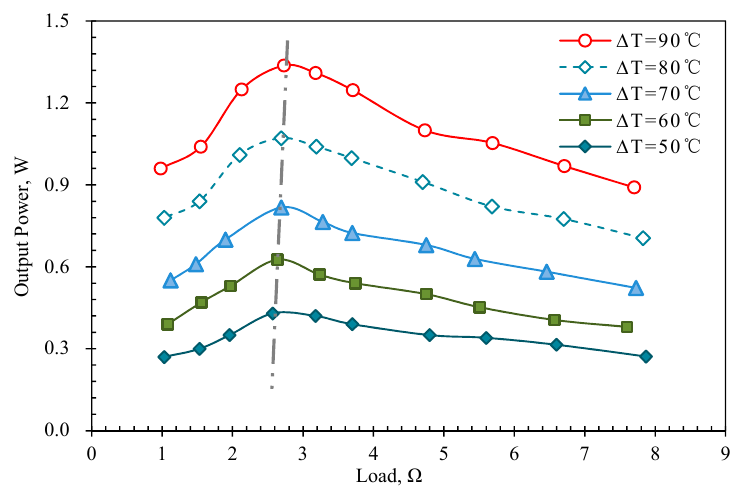
Figure 2. The relationship between load and output power for single module at different ∆ T .